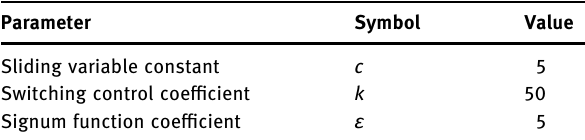
Table 2: SMC parameters